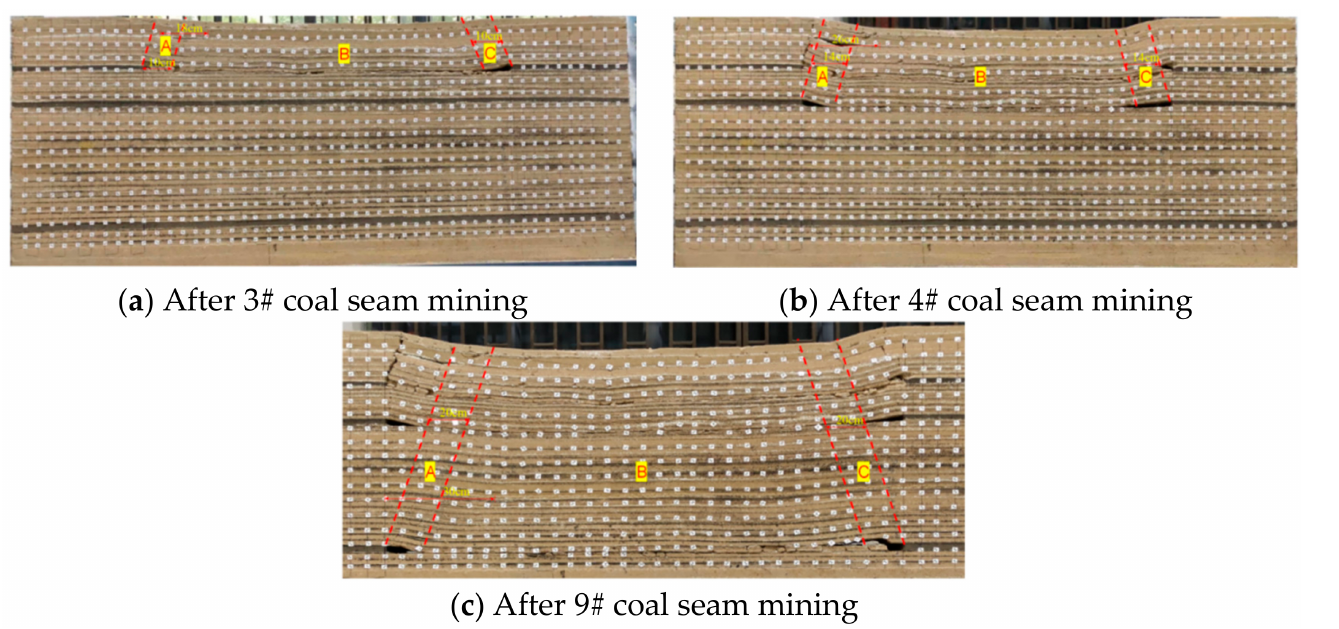
Figure 12. Zoning map of residual fractures in the